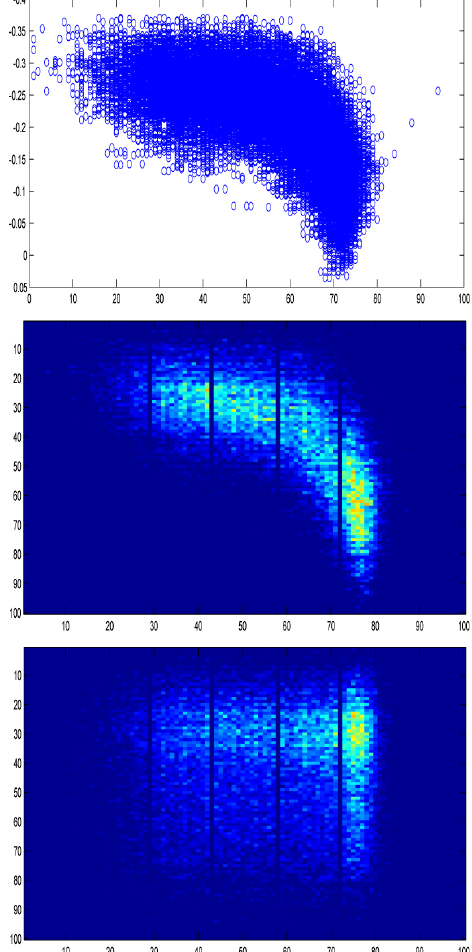
Fig. 11. Phase plane (top), binned version (middle) and binned ver- sion with a random shuffling of the data (bottom). The temperatures are the minimum ones at Greensboro, Alabama, from 1 February 1890 through 31 December 2011.